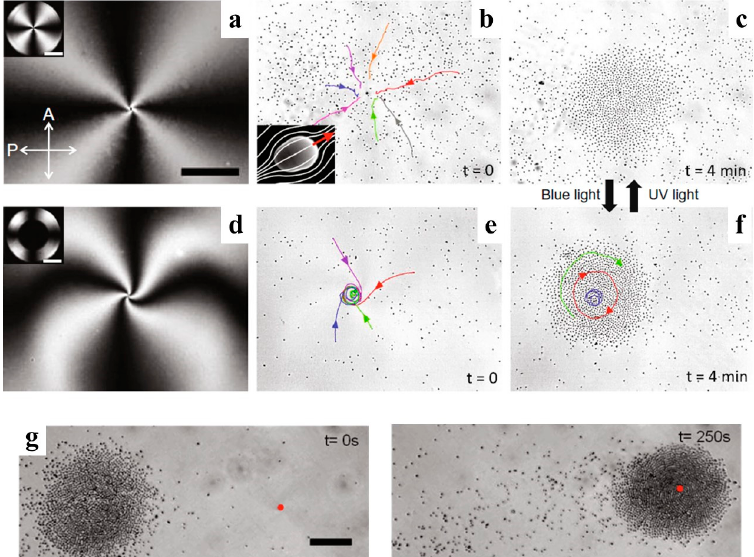
Figure 5. Reconfigurable swarming of anisometric particles driven by LCEP observed by Hernàndez-Navarro et al. [39] . ( a ) Image of photoactivated texture of LC with radial configuration; ( b , c ) Formation of colloidal aster by LCEP; ( d ) Image of photoactivated texture of LC with spiral configuration; ( e , f ) Assembly of a rotating cluster by LCEP; ( g ) LCEP swarming of particles by in situ reconfiguration of LC director field. Adapted with permission from [39].